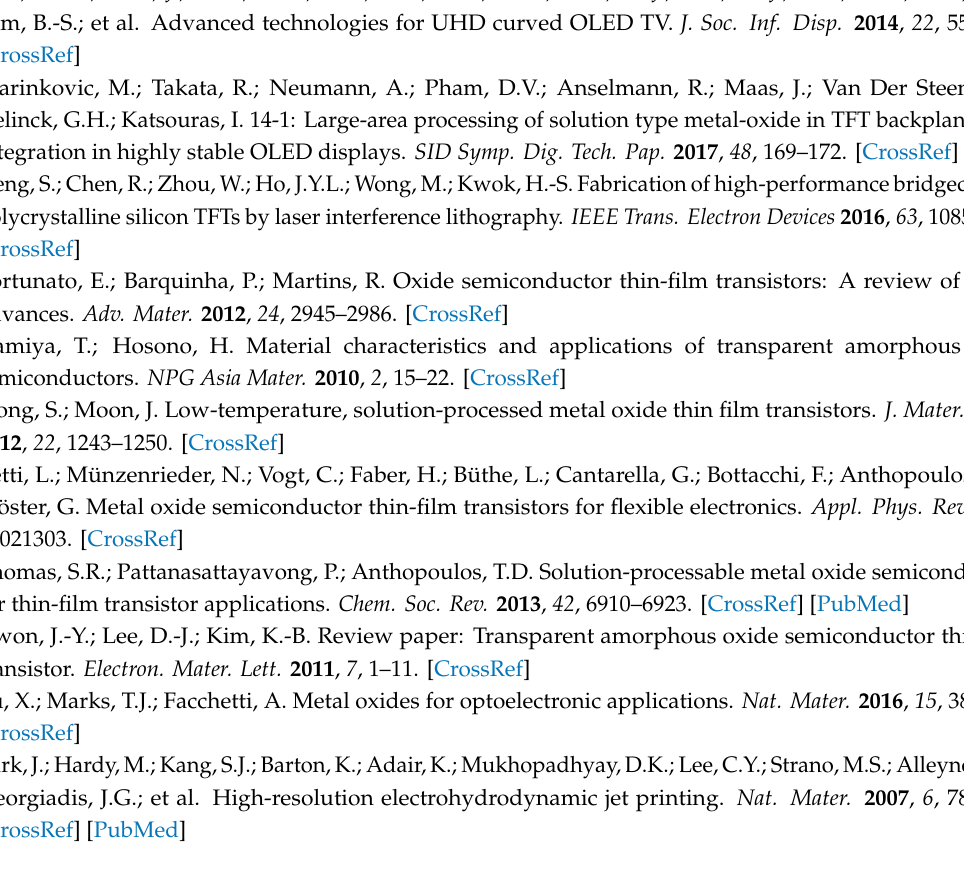
Figure S1: OM images of ZTO-printed layers with micro-dripping and cone-jet mode. Figure S2: Transfer characteristics with ZTO TFTs with 300 and 400 ◦ C thermal annealing condition. Figure S3: OM and SEM images of EHD jet-patterned